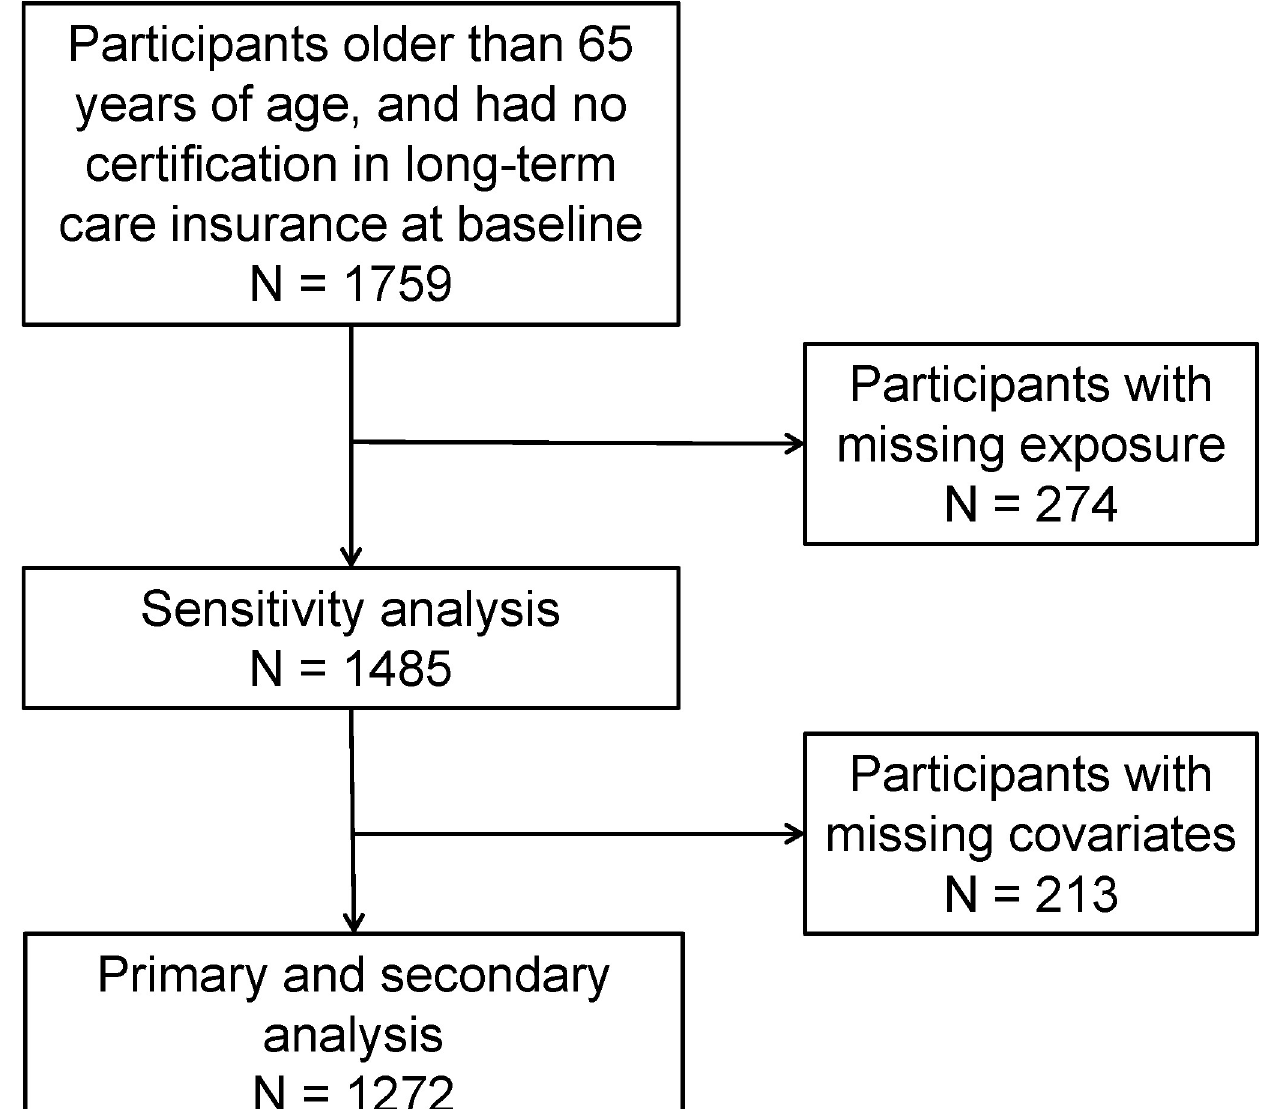
Fig 1. Flow chart of the study